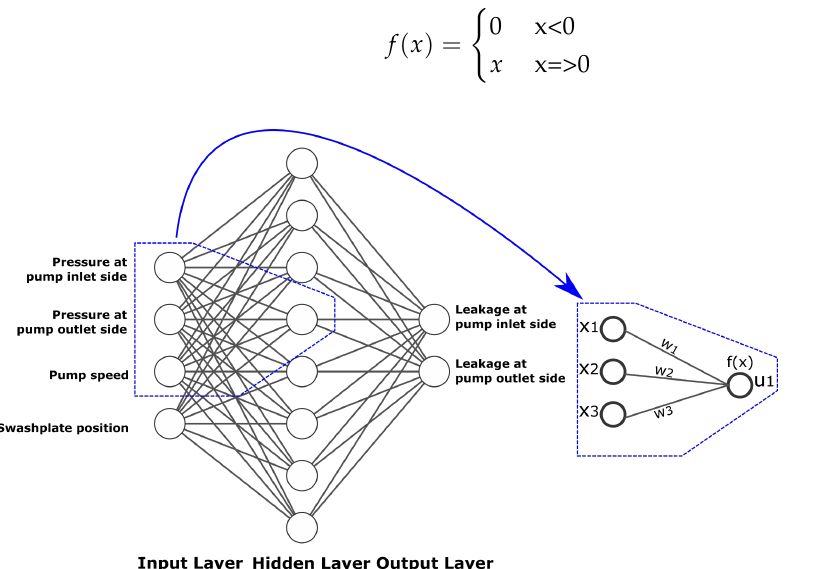
Figure 4. A three layer feed forward neural network with description of artificial